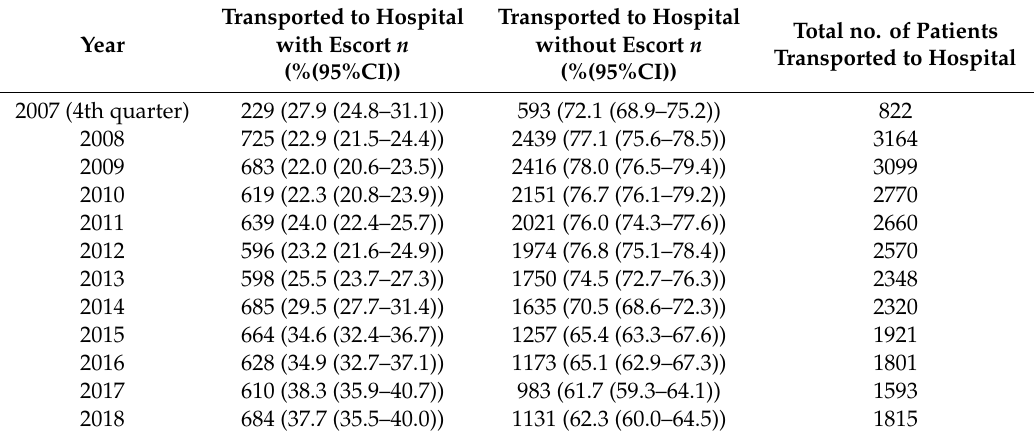
Table 1. Development in the number of transported patients over the years 2007–2018. Data presented as numbers (percentages (95% CI)).